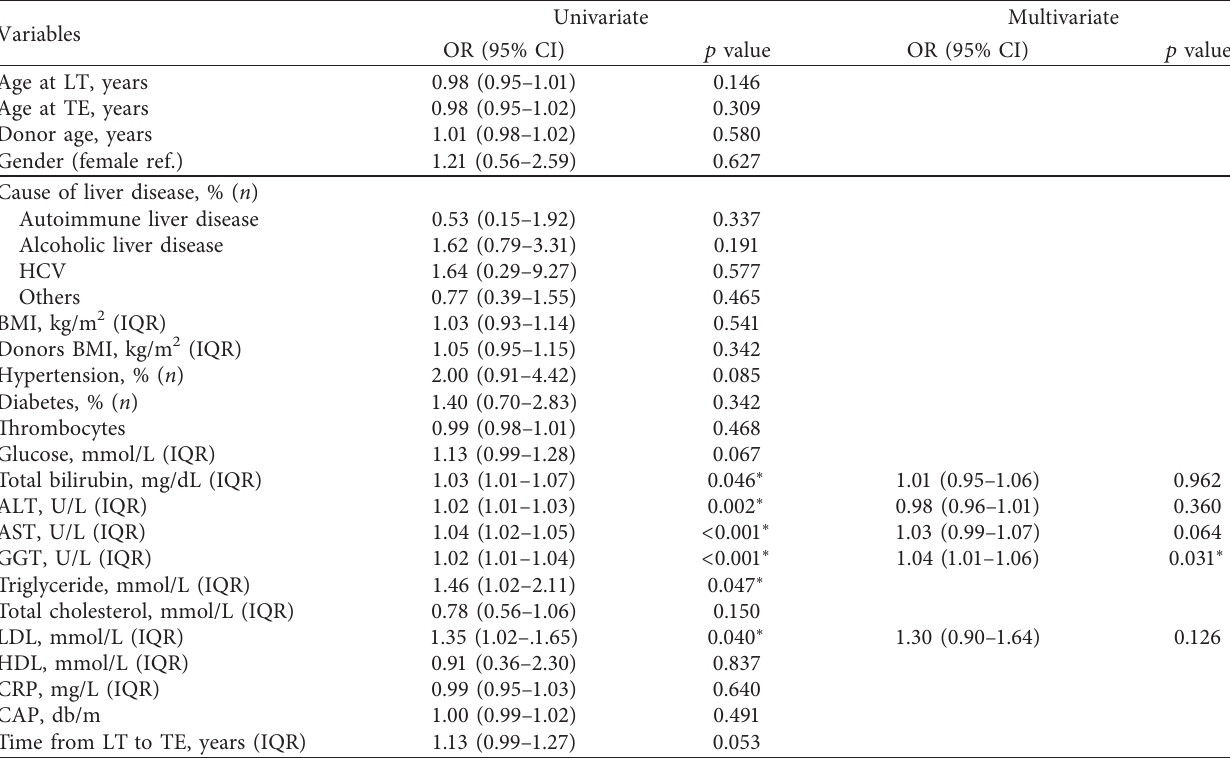
Table 8: Univariate and multivariate analysis of predictors of advanced